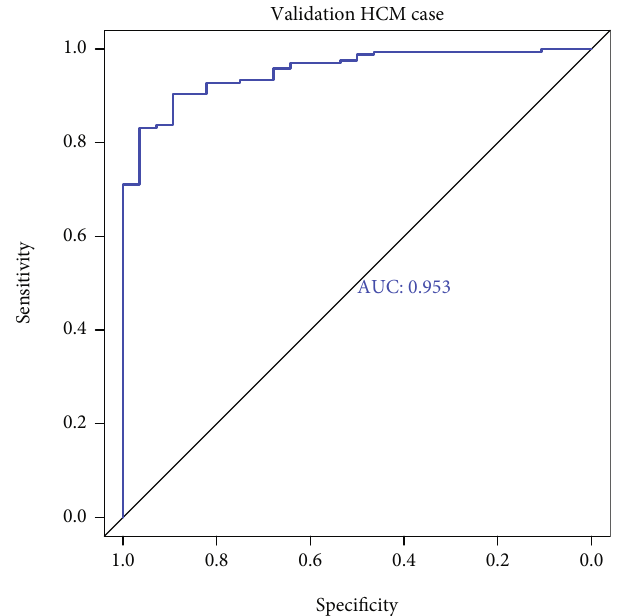
Figure 6: Receiver-operating characteristic (ROC) curve of the validation